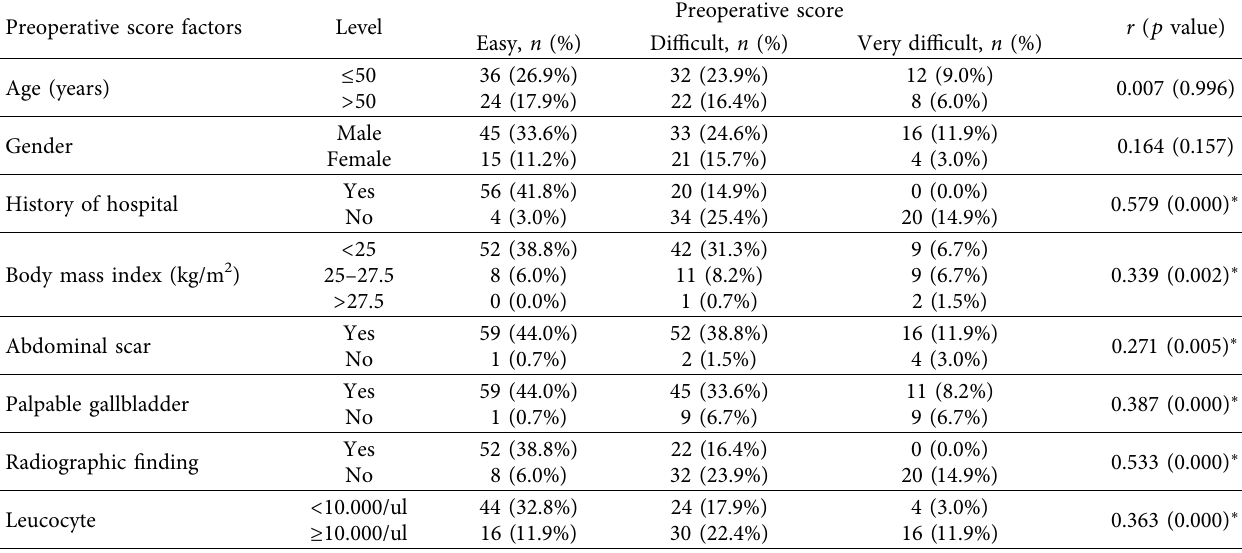
Table 5: Relationship of risk factors with preoperative score.